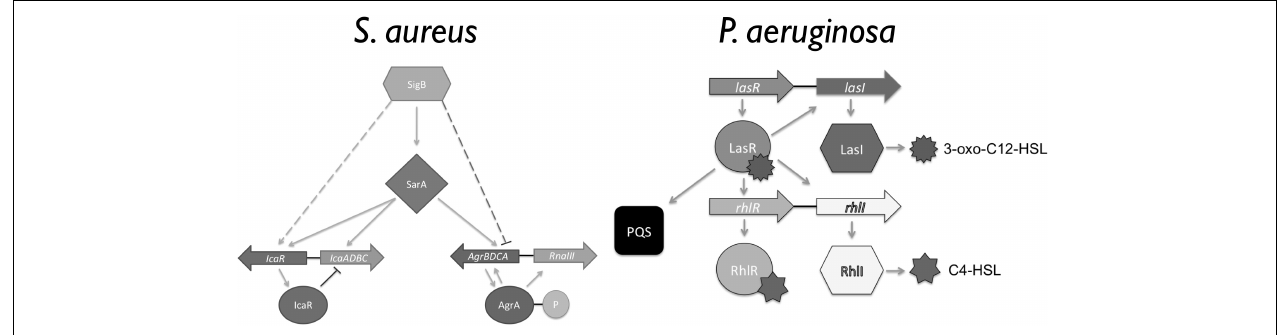
FIGURE 1 | Overview of the Staphylococcus aureus and Pseudomonas aeruginosa quorum sensing (QS) hierarchy (Adapted from Pearson et al., 1997; Le and Otto, 2015).